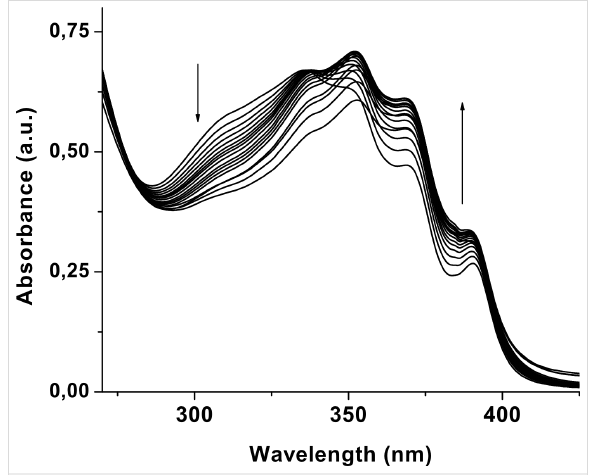
Figure 8: Change in absorbance of 1 ( c = 4.31 × 10 − 5 M) upon gradual addition of tetrabutylammonium salts of L- N- acetylvaline.